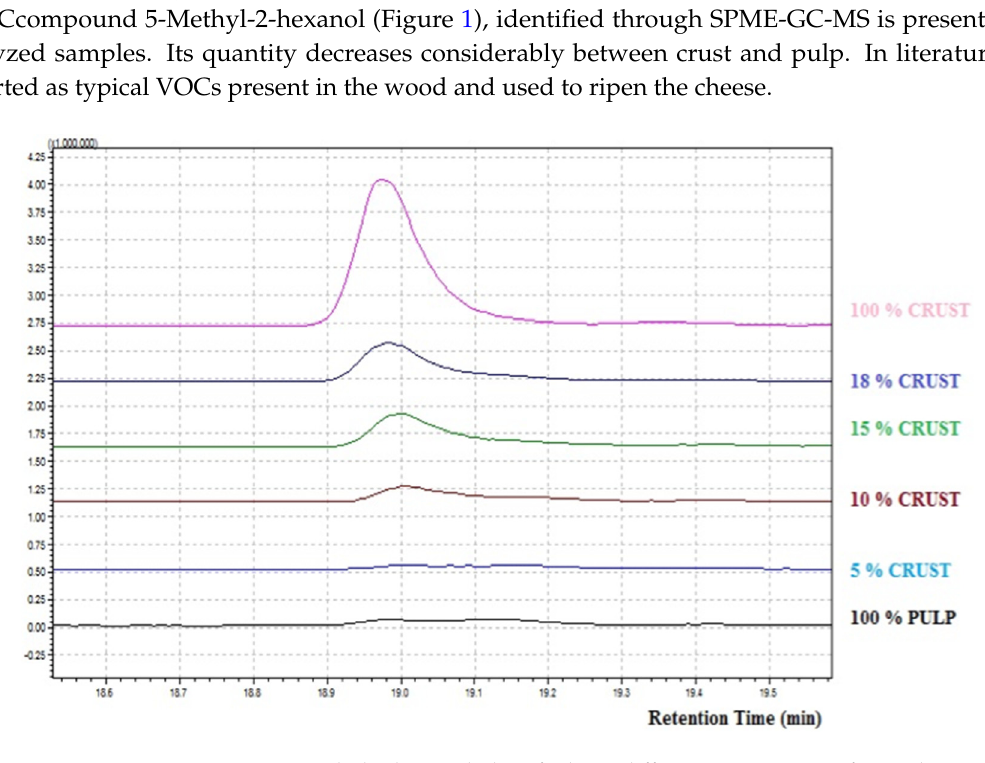
Figure 2. PG1 and CG2 PCA Score PLOT with different crust percentages.